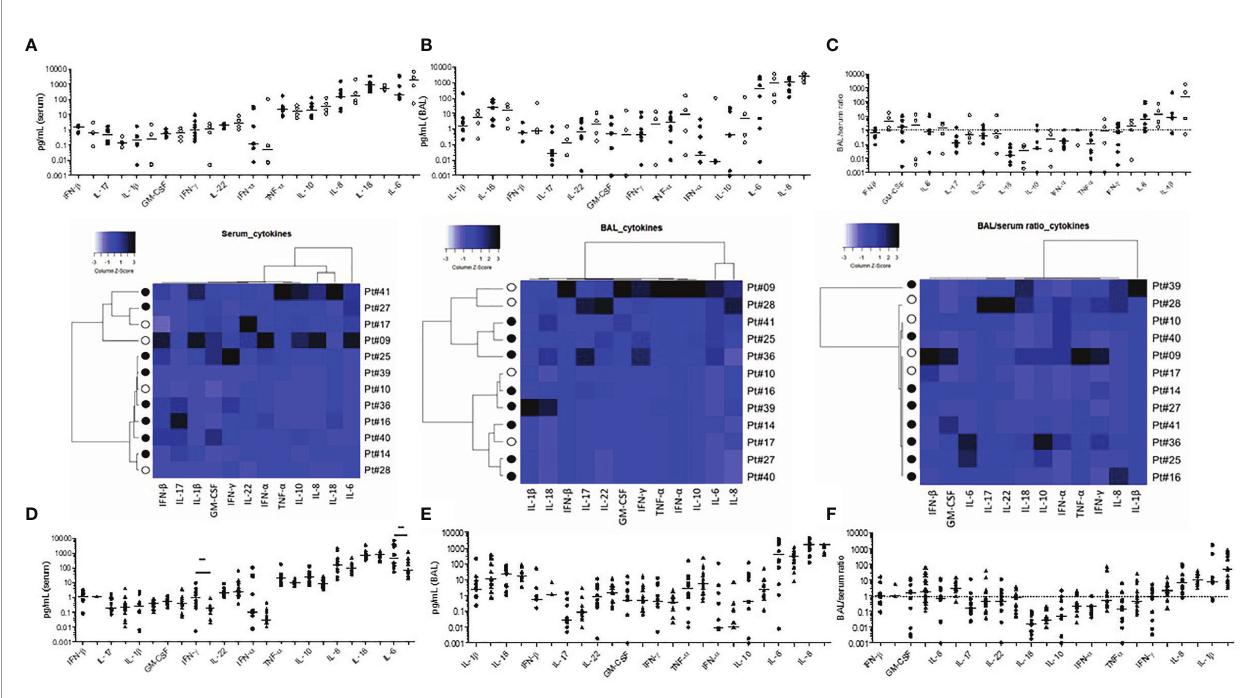
FIGURE 3 | Serum and bronchoalveolar supernatant cytokine levels in severe COVID-19 infection. First-wave serum (A) and BAL (B) cytokine levels in survivors (n=8, black symbols), and deceased patients (n=4, open symbols). The BAL/serum ratio is shown in (C) . Heatmaps represent individual data of survivors and deceased patients and cytokine orders in whole Figure 3 follow the hierarchical clustering of the corresponding heatmap. Cytokine serum (D) , BAL (E) , and BAL/ serum ratio (F) levels for fi rst- wave patients (rounded symbols) and second-wave patients